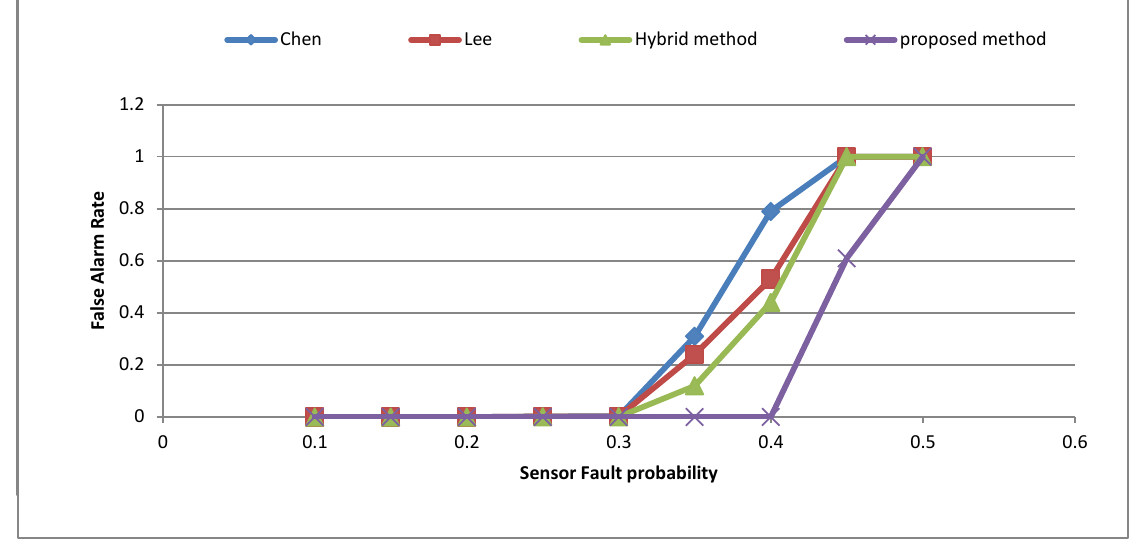
Figure 8. False alarm rate when N